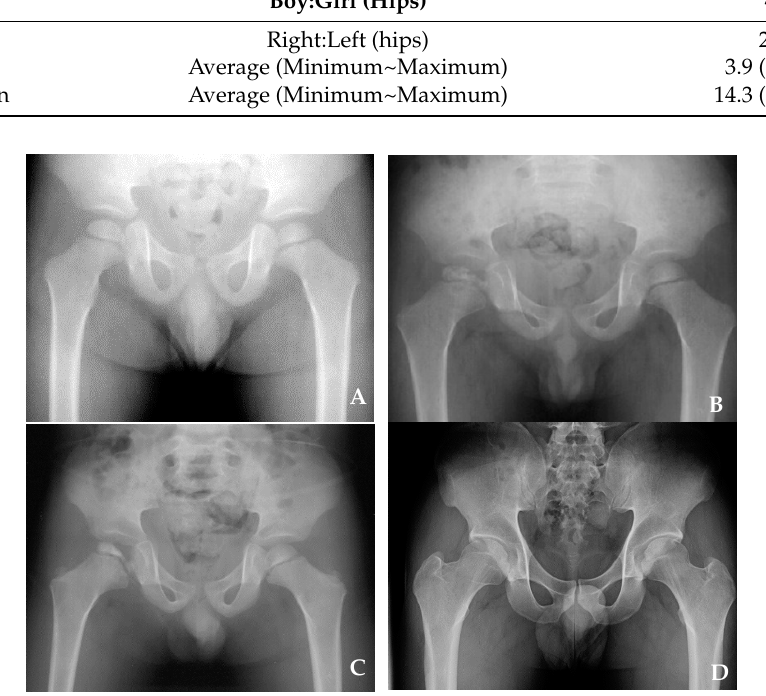
Figure 1. Anteroposterior radiograph of patients at the age of 2 years. Initial ( A ), fragmentation ( B ), reossification ( C ), and residual ( D ) stages.